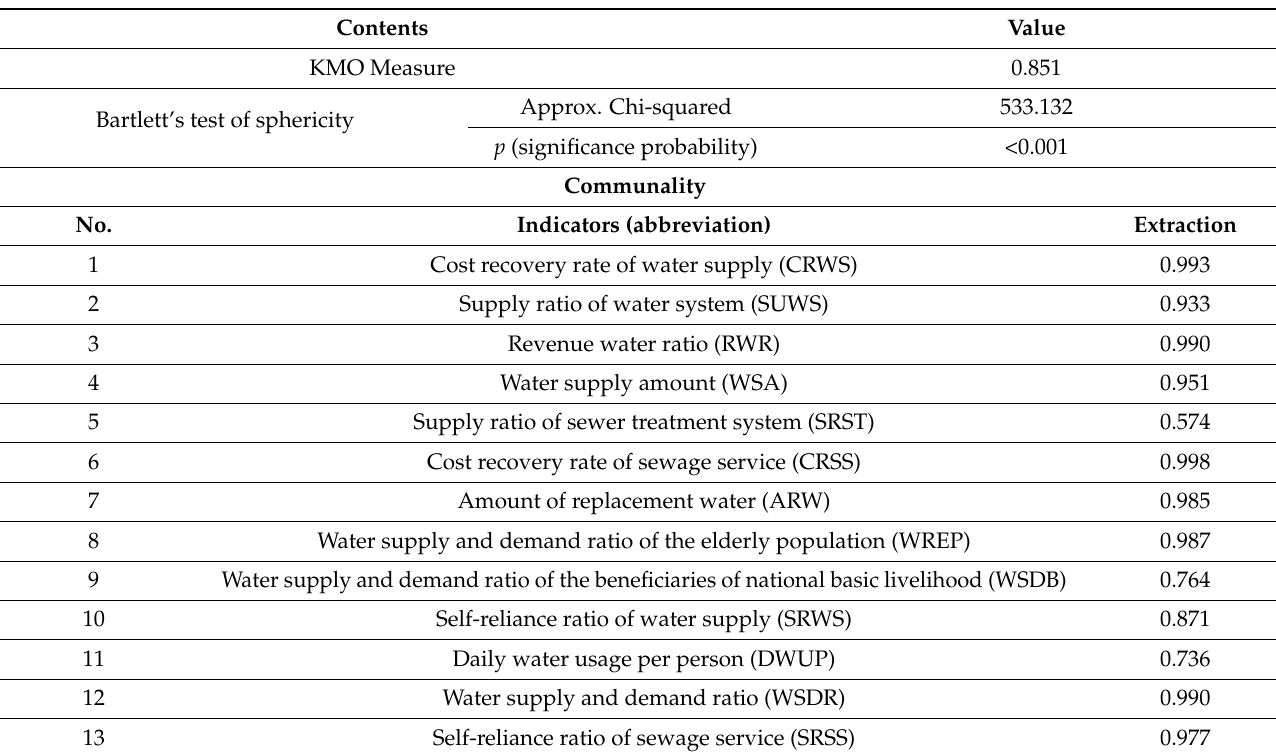
Table 6. Results of KMO, Bartlett’s test and communality values of the indicators except two Heywood case.